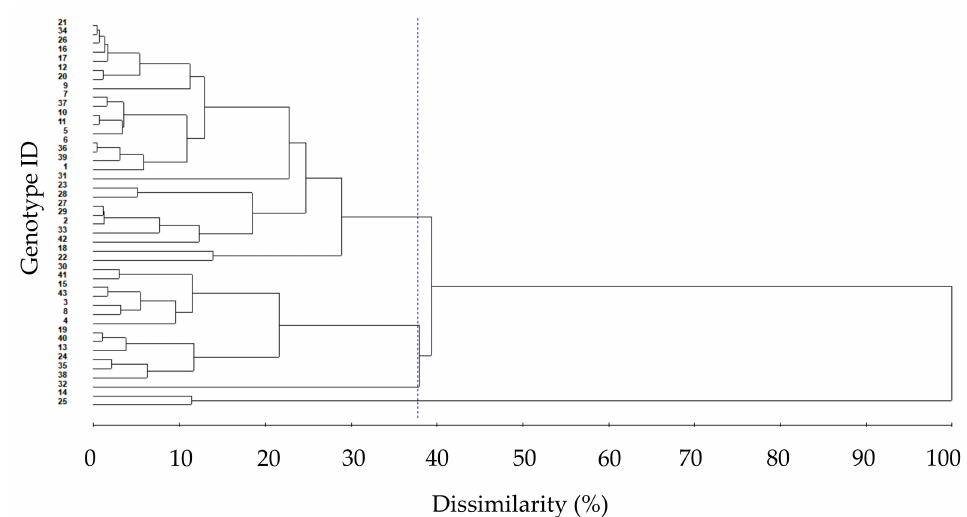
Figure 2. Dissimilarity within 43 C. canephora genotypes using the Mahalanobis distance and the unweightedpairgroupmethodwitharithmeticmean(UPGMA),consideringfourroottraits(root length density, root volume, root superficial area, and root diameter) and six soil depths (0–10, 10–20, 20–30, 30–40, 40–50, and 50–60 cm).